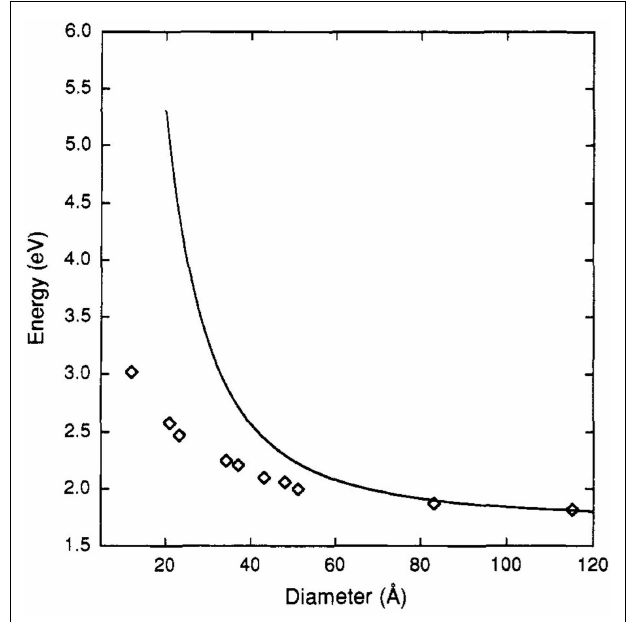
FIGURE 12 | Influences of shape on the optical properties of CdSe QDs . (A) Ultraviolet-visible (UV-Vis) and photoluminescence (PL) spectra of CdSe QDs. (B) UV-Vis and PL spectra of CdSe QDs. (C) PL spectra of core/shell QDs with different shell thickness. (D) Polarization resolved PL spectra of CdSe QDs (Xiaogang et al.,